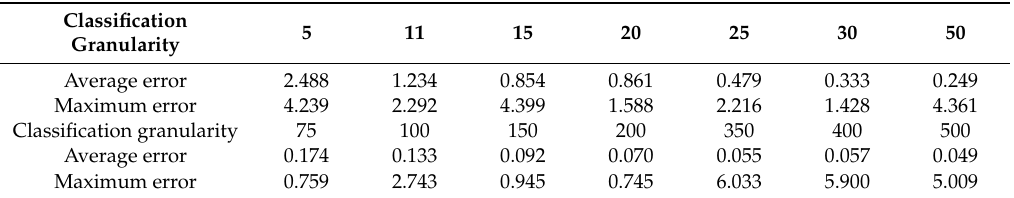
Table 2. Torque classifications and error